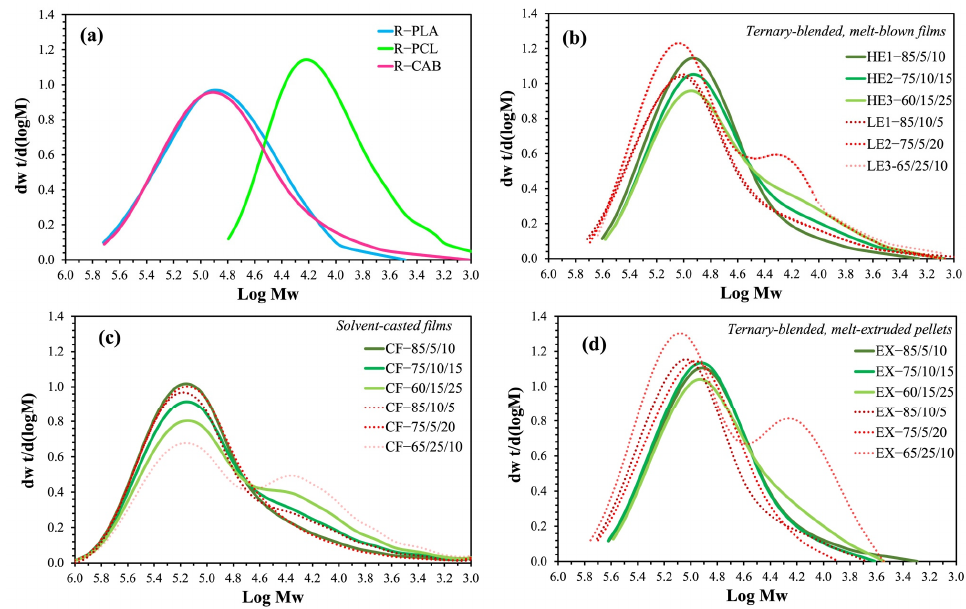
Figure 7. GPC traces of: ( a ) PLA, PCL and CAB pellets from raw materials, ( b ) ternary-blended, meth-blown films of PLA/PCL/CAB (HE and LE films), ( c ) solvent-casted films of PLA/PCL/CAB and ( d ) ternary-blended, melt-extruded pellets.